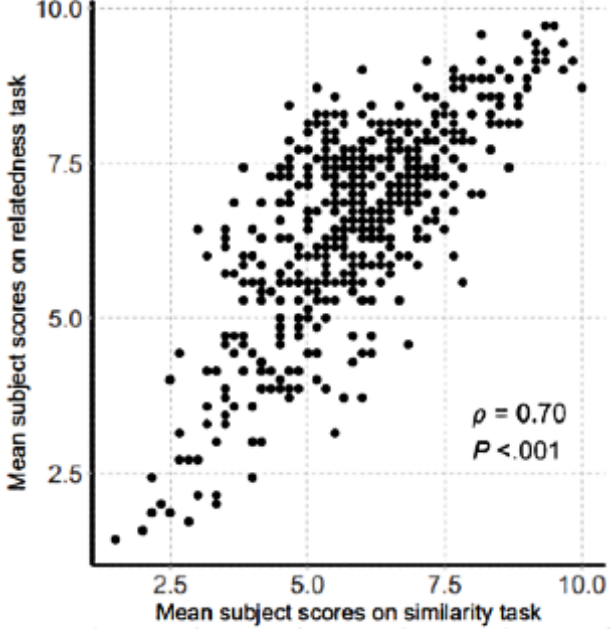
Figure 2. Scatter plot of the correlation between the similarity and relatedness